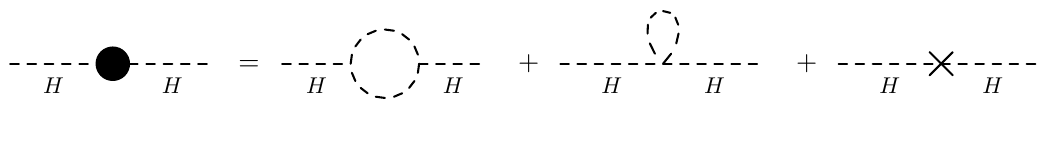
Figure 20 . Feynman diagrams contributing to P [ HH